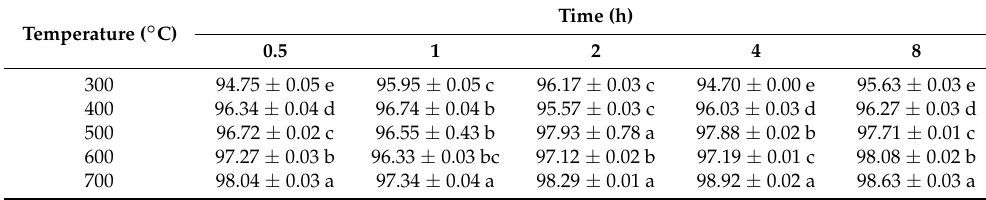
Table 5. The removal efficiency (%) of fluoranthene in soils by calcination